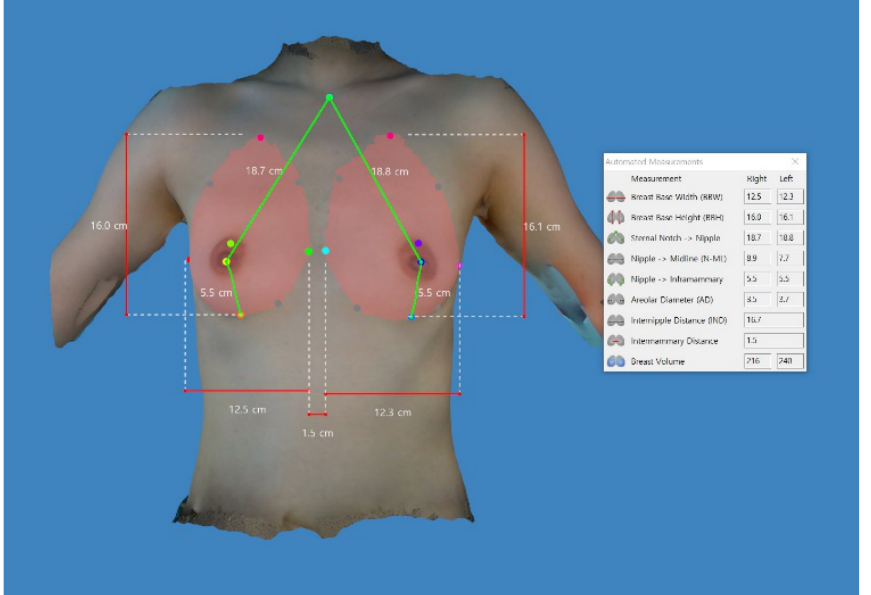
Figure 6. Preoperative simulation of the postoperative outcomes using the Divina™ 3-dimensional scanner. The anthropometric measurements are preoperatively obtained; these include breast base width, breast base height, distance from the sternal notch to the nipple, distance from the nipple to the midline, distance from the nipple to the inframammary fold, breast volume, internipple distance and intermammary distance.